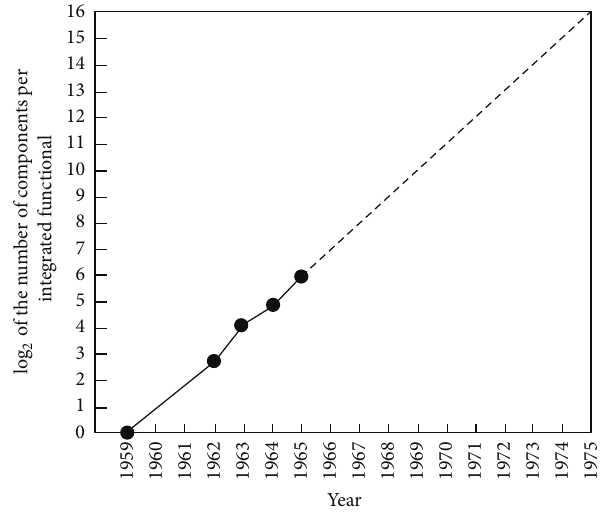
Figure 1: Moore’s prediction, in 1965, of the doubling of the number of minimum cost components on a chip per year, with extrapolated to 1975